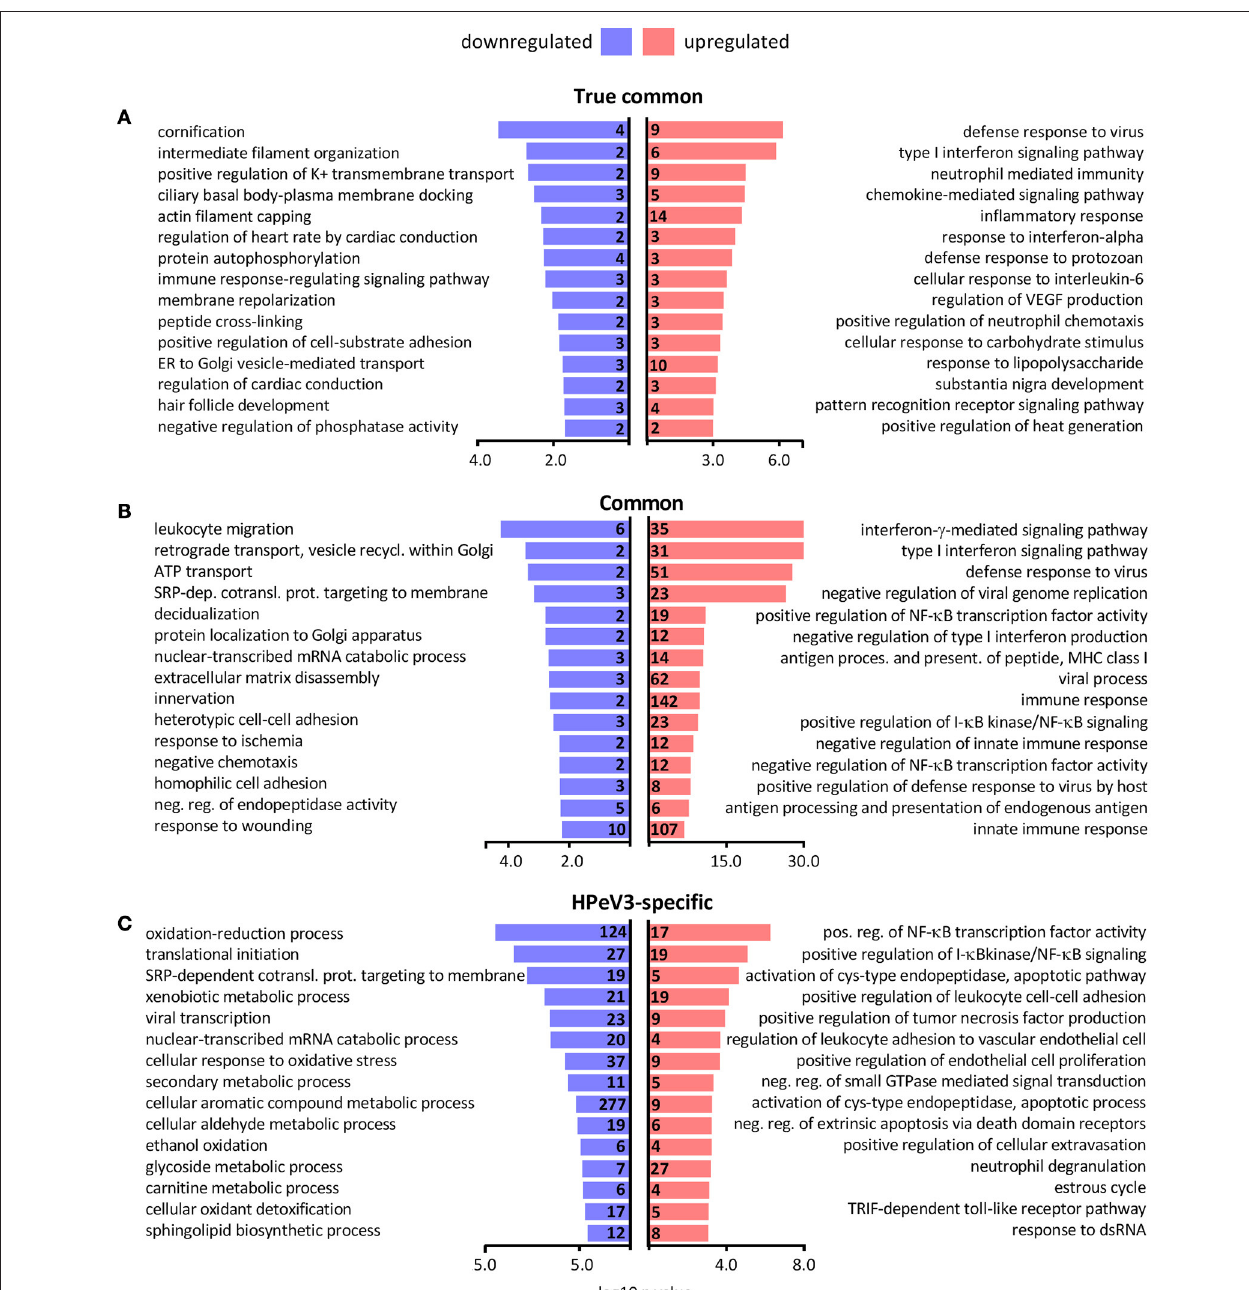
FIGURE 5 | Top 15 most significantly over-represented biological processes among the gene ontologies of the (A) true common, (B) common and (C) HPeV3-specific up- and downregulated DEG subsets. Number of DEGs associated with each biological process shown along y-axis and -log10 p -values on the